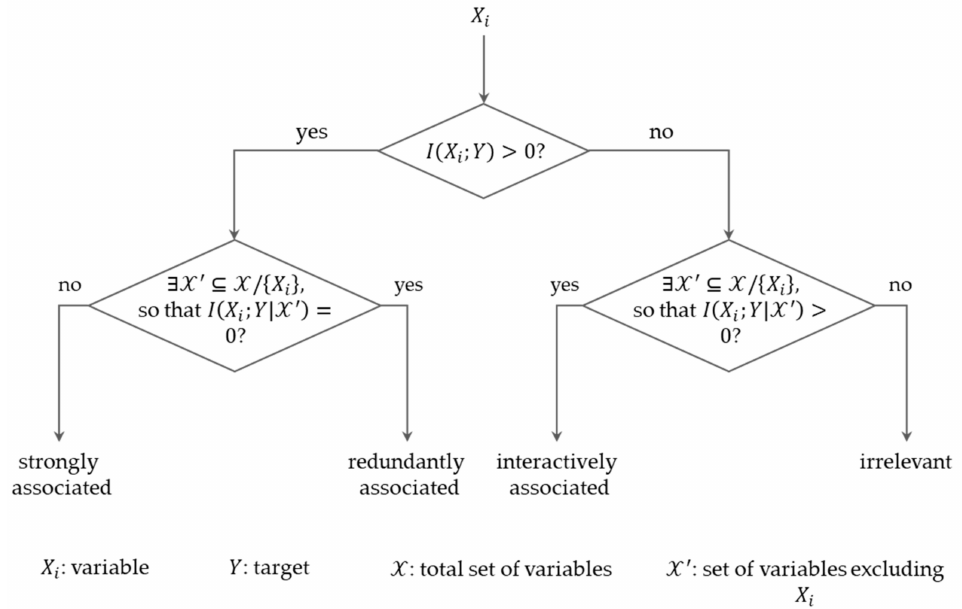
Figure 4. Flowsheet diagram of variable differentiation from the information-theoretical